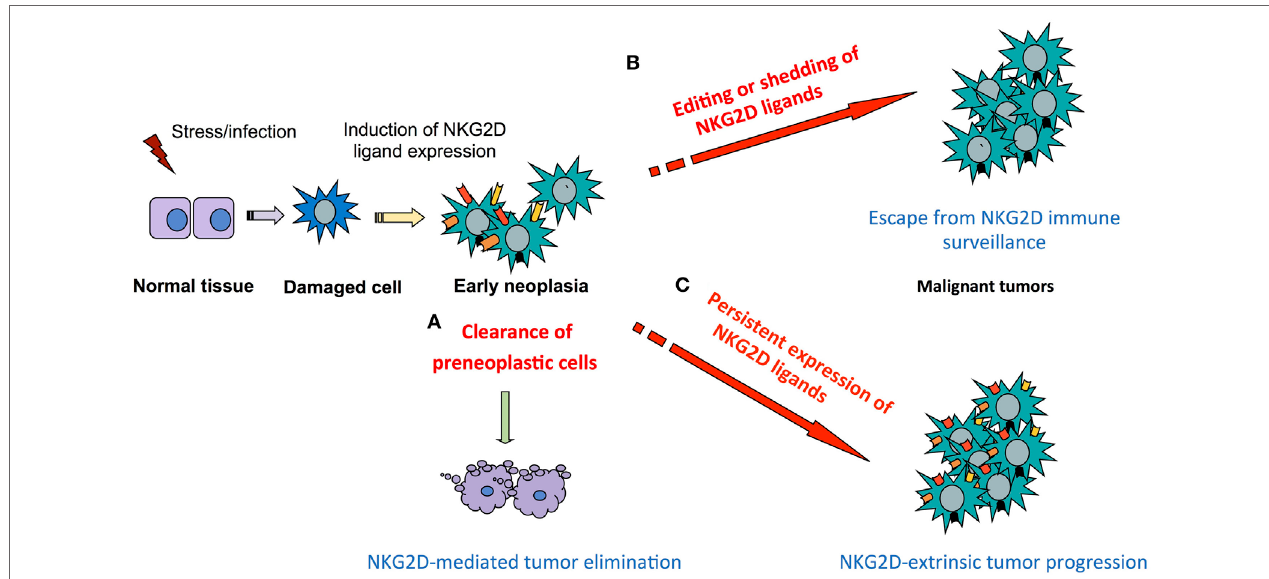
FiGUre 4 | Principles of NKG2D dual function in tumor immunity. Induction of NKG2D ligand on stressed or damaged tissues initiates a local immune response via NKG2D-expressing cells that progresses according to four non-exclusive scenarios. (a) Clearance of neoplastic cells preventing or delaying tumor formation as seen in mouse models of E μ myc driven B-cell lymphoma and leukemia and aggressive prostate tumors in the transgenic adenocarcinoma of mouse prostate (TRAMP) mouse model. (B) Failure to eliminate tumors due to NKG2D ligand editing as seen in a fraction of aggressive prostate tumors in the TRAMP mouse model or to ligand shedding and subsequent NKG2D downregulation and effector desensitization, as described in advanced human cancer with poor prognosis. (C) Persistent expression of NKG2D ligands at high levels exacerbates the pro-tumorigenic milieu via NKG2D-mediated immune responses in models of inflammation-driven cancer such as hepatocellular carcinoma and fibrosarcoma